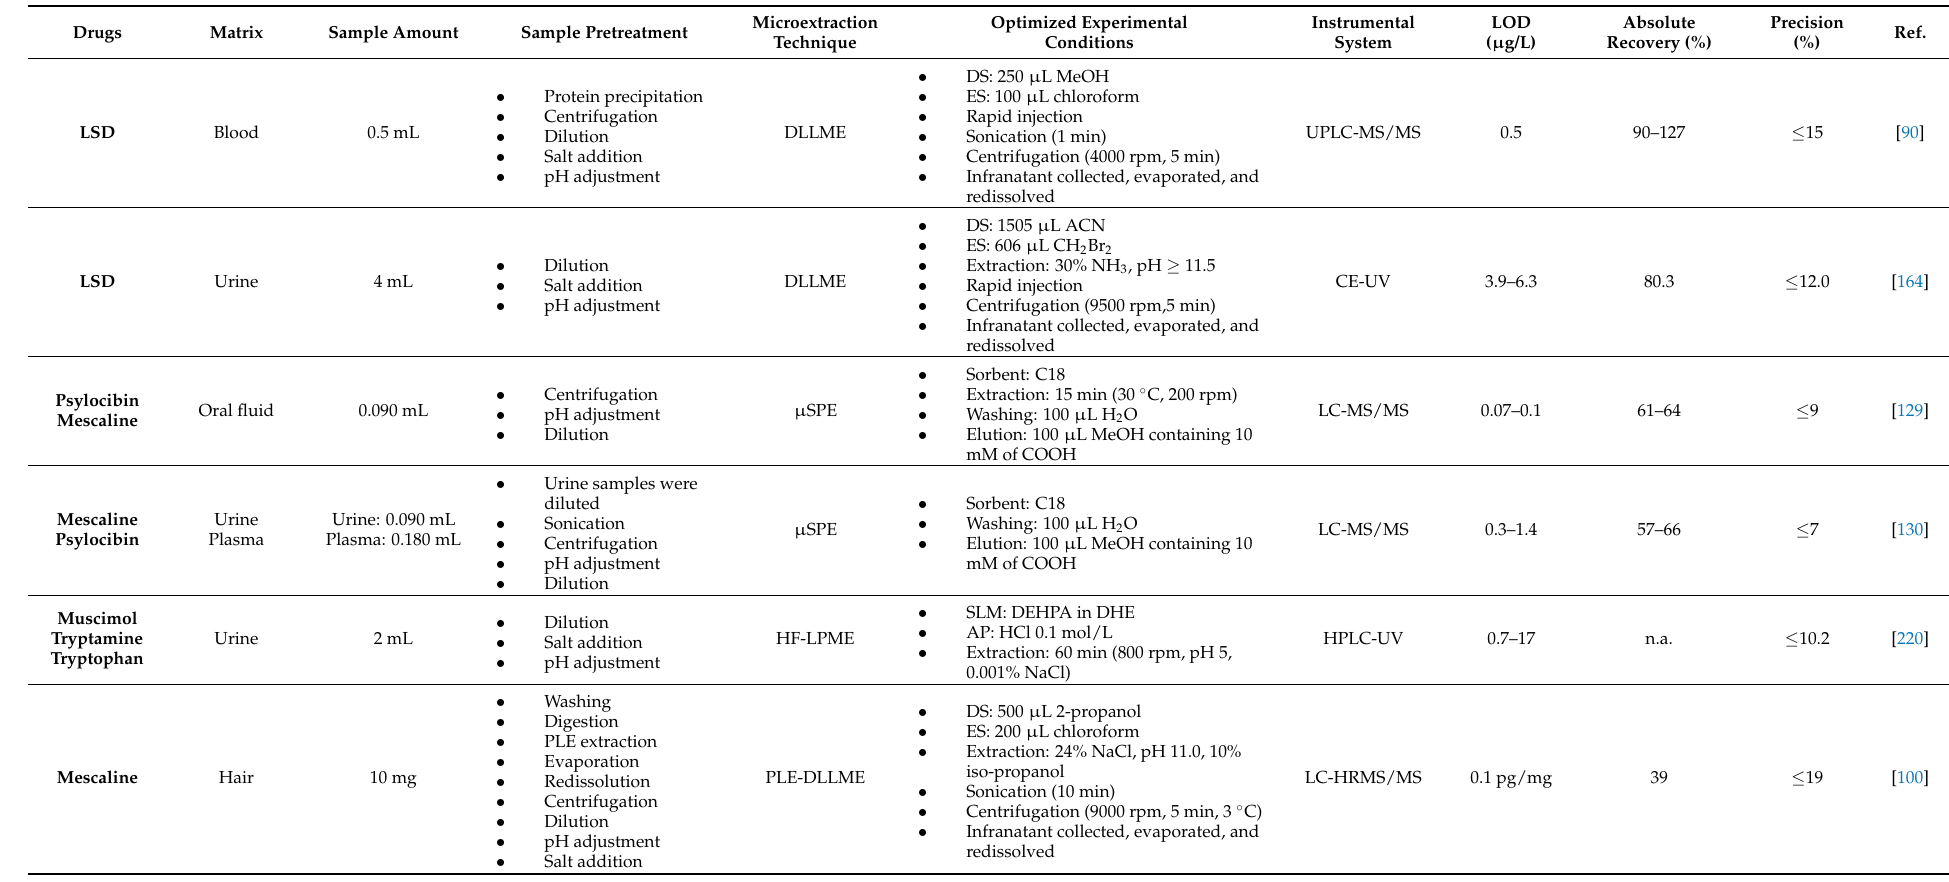
Table 5. Microextraction-based approaches for the analysis of hallucinogenic drugs and related substances in the forensic